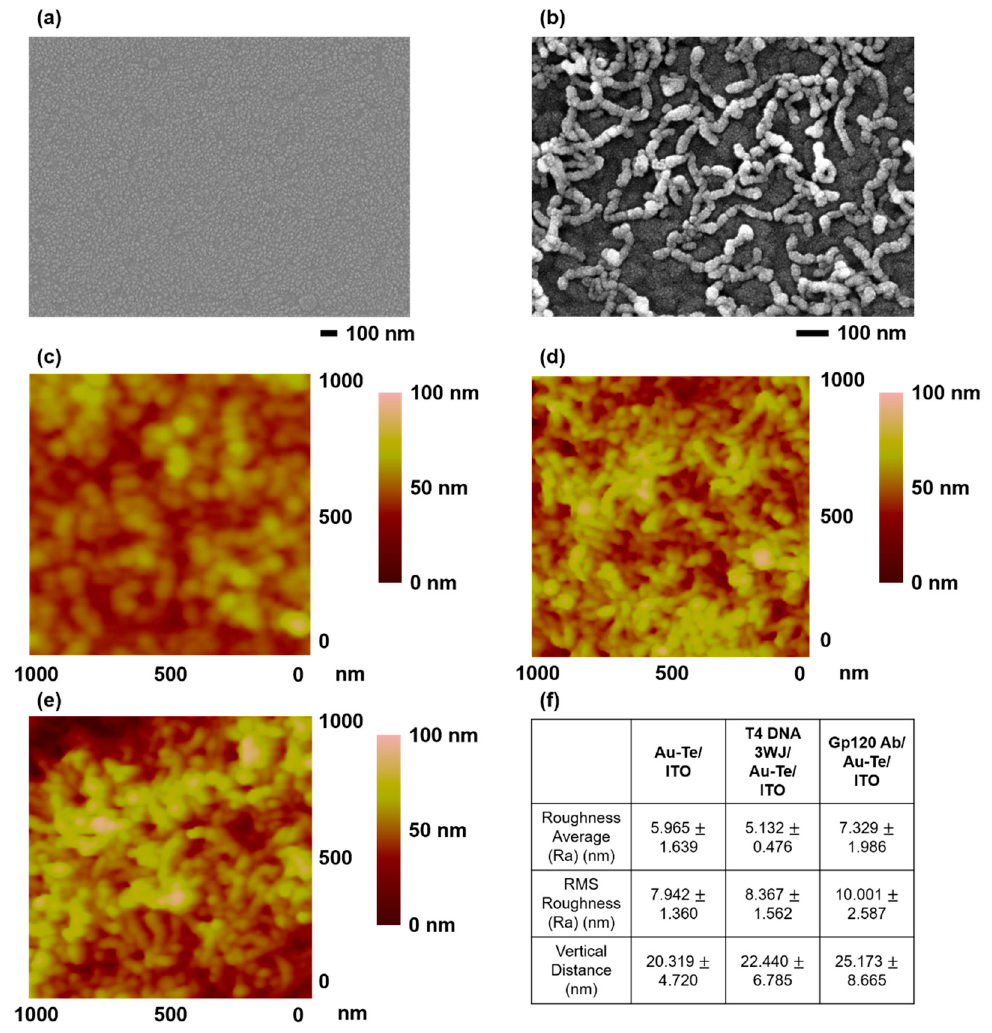
Figure 2. Field emission scanning electron microscopy (FE-SEM) image of ( a ) Bare indium-tin-oxide (ITO), ( b ) Au–Teon ITO. Atomic force microscopy (AFM) image of ( c ) Au–Te / ITO, ( d ) T4 DNA 3WJ / Au–Te / ITO, ( e ) GP120 antibody / Au–Te / ITO. ( f ) Surface roughness analysis of the Au–Te / ITO, T4 DNA 3WJ / Au–Te / ITO, and GP120 Ab / Au–Te / ITO (The surface roughness analysis was carried out at 10 di ff erent positions on the AFM images,